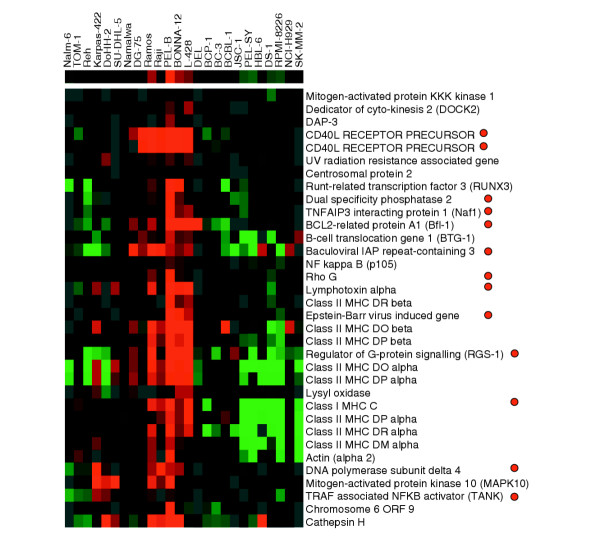
Visualization of average linkage HC using the programs Cluster and Treeview [5] of the NFκB responsive gene cluster identified from consensus clustering and functional annotation. The sample names correspond to different leukemia and lymphoma samples [21], with the NFκB-responsive gene cluster being predominantly expressed in the cell lines Raji, PEL-B, EHEB, BONNA-12 and L-428. Gene names with red circles represent those genes that contain one or more NFκB-binding sites in the region up to 1,000 bp upstream from the putative transcriptional start site.